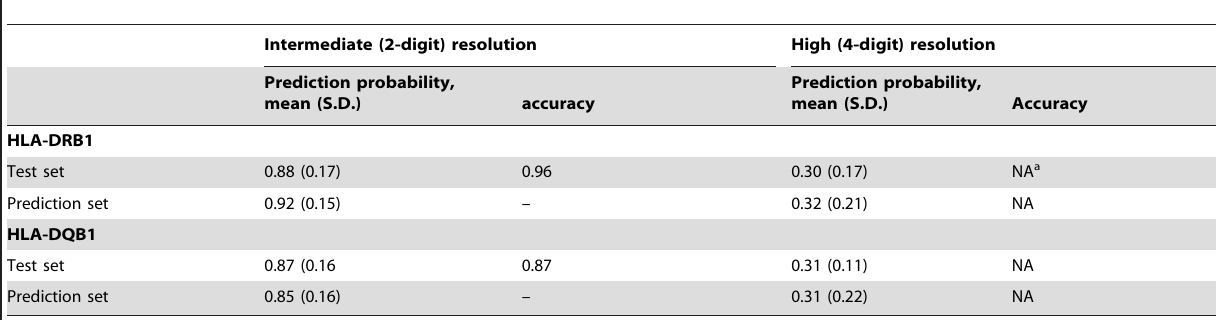
Table 1. Prediction probability and accuracy of predicting HLA-DRB1 and -DQB1 alleles.